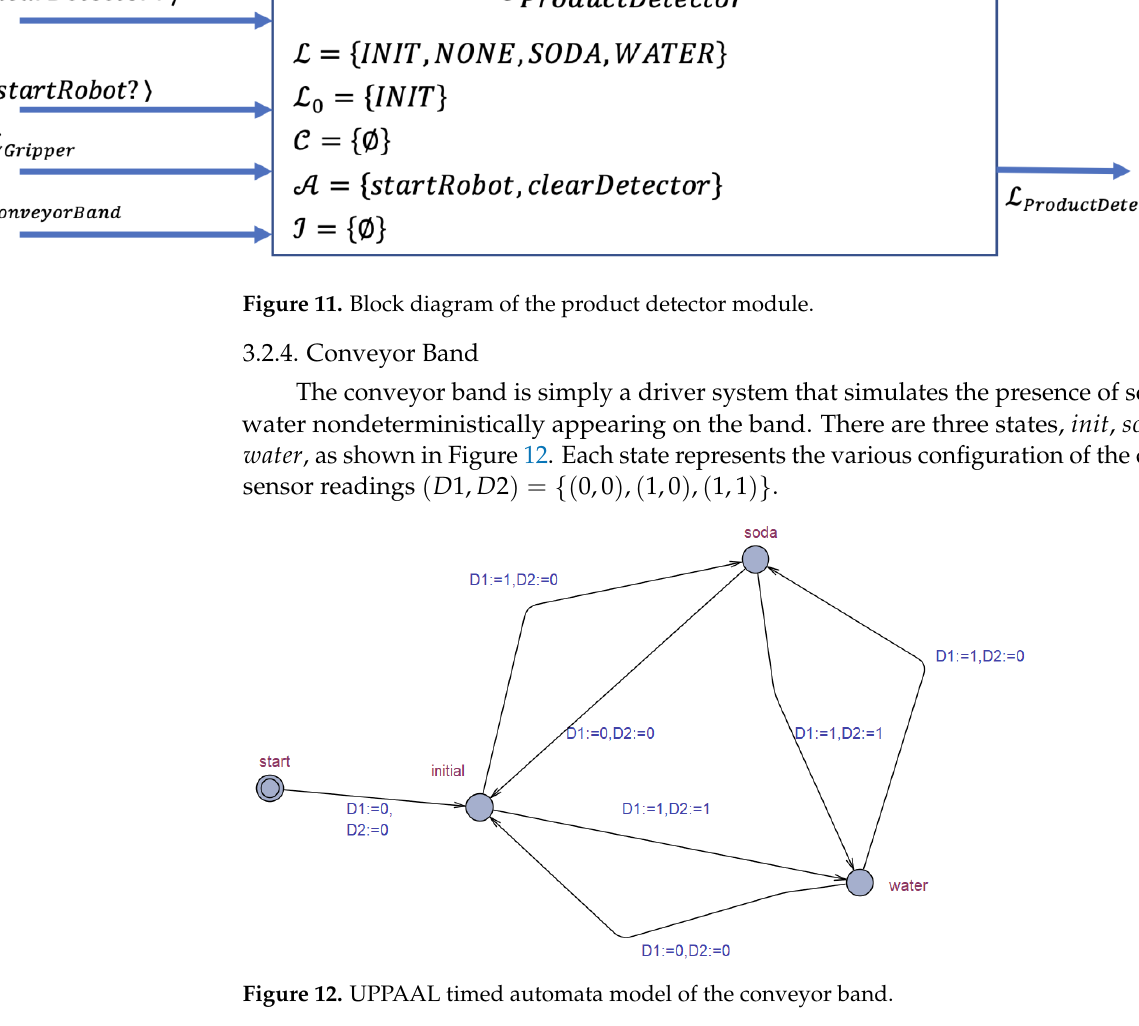
Figure 11. Block diagram of the product detector module.